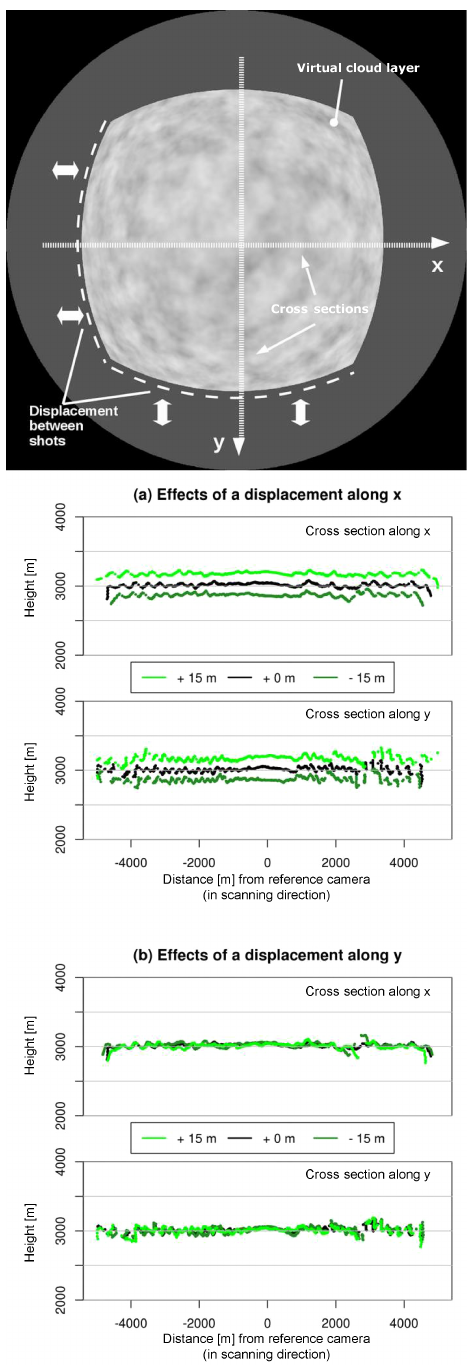
Figure 13. Simulation of an asynchronous recording by the stereo cameras for the same area size. A virtual cloud layer at 3km height was displaced between the two recordings of the stereo cameras by ± 15m (a) along the baseline ( x direction) and (b) in perpendicular direction ( y axis). Plots show the respective cross sections in x and y direction of the reconstruction for each